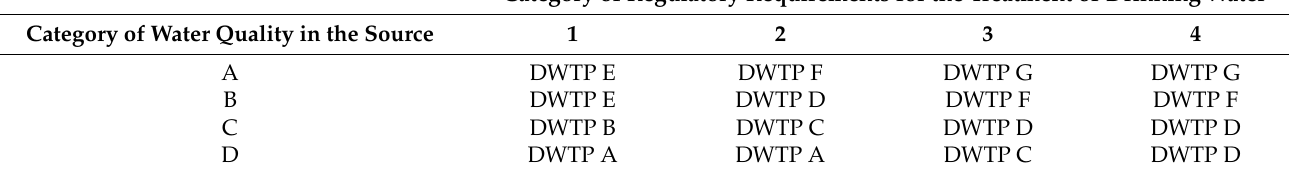
Table 4. Scheme used by WaterProof for the definition of the typical DWTP suggested by the system considering the analysis presented by